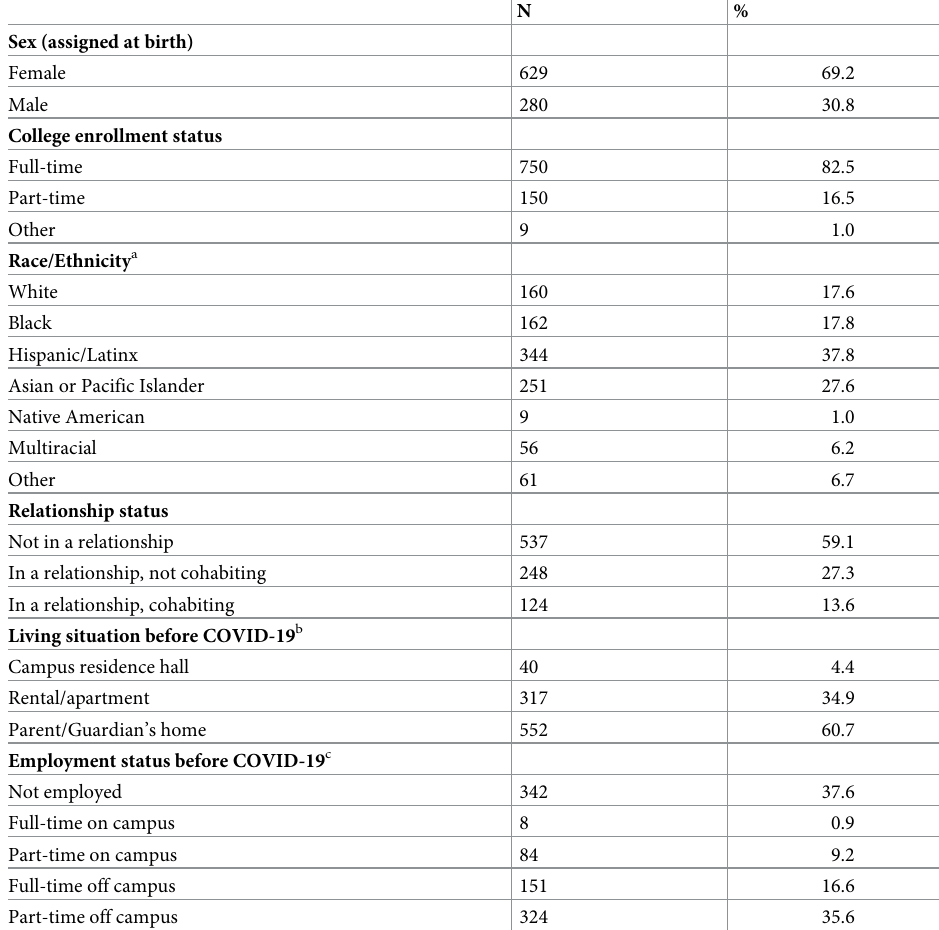
Table 1. Socio-demographic characteristics of the student survey sample (N =